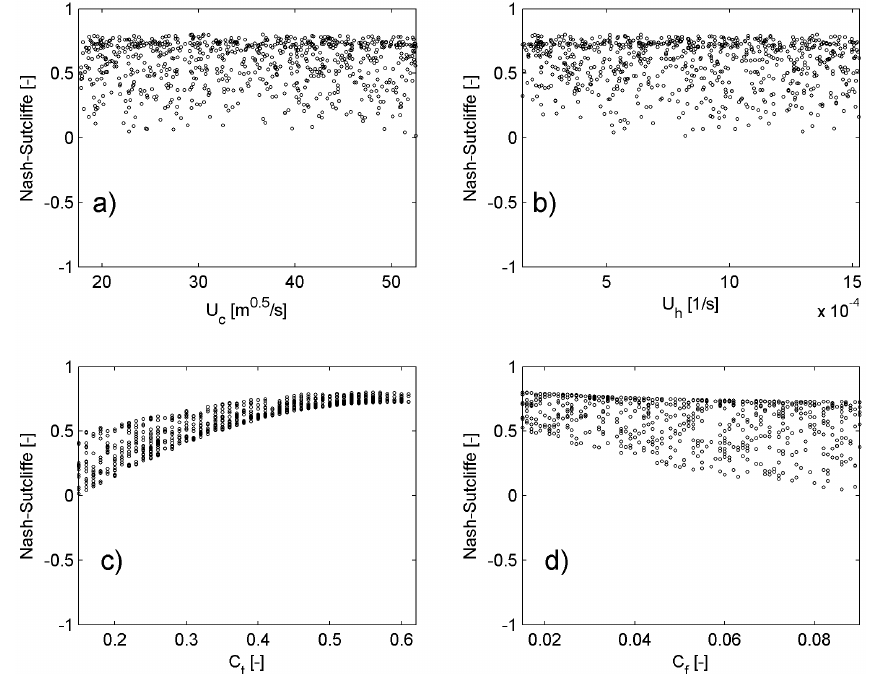
Figure 10. The Orba basin, August–October 2011. Dotty-plot representation of the NS on mean SWI at basin scale. Each subplot reports the parameter value on x axis and the value of NS statistic on y axis. The parameter c t (c) has a quite clear range where NS reaches maximum values independently from the other parameters. This occurs even for parameter c f although the independence is weaker (d) . No independence is evident for the surface parameters (a, b)